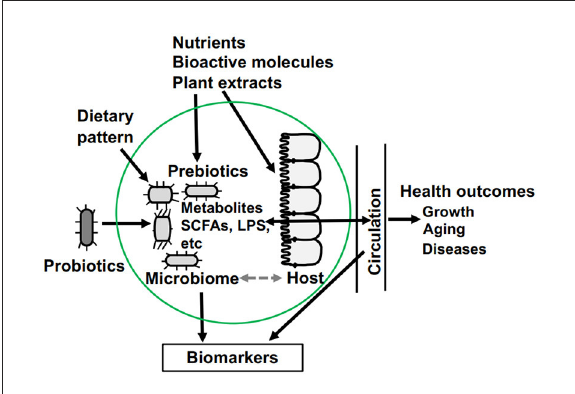
FIGURE1 The complex connections among dietary factor, gut microbiota, and hosts. SCFAs, short-chain fatty acids; LPS,